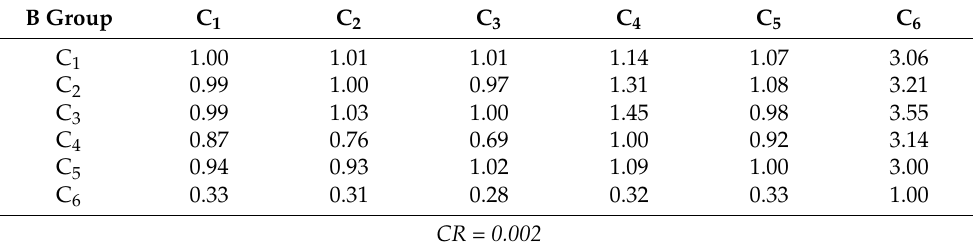
Table 6. Aggregated pairwise comparison matrix for group B. B